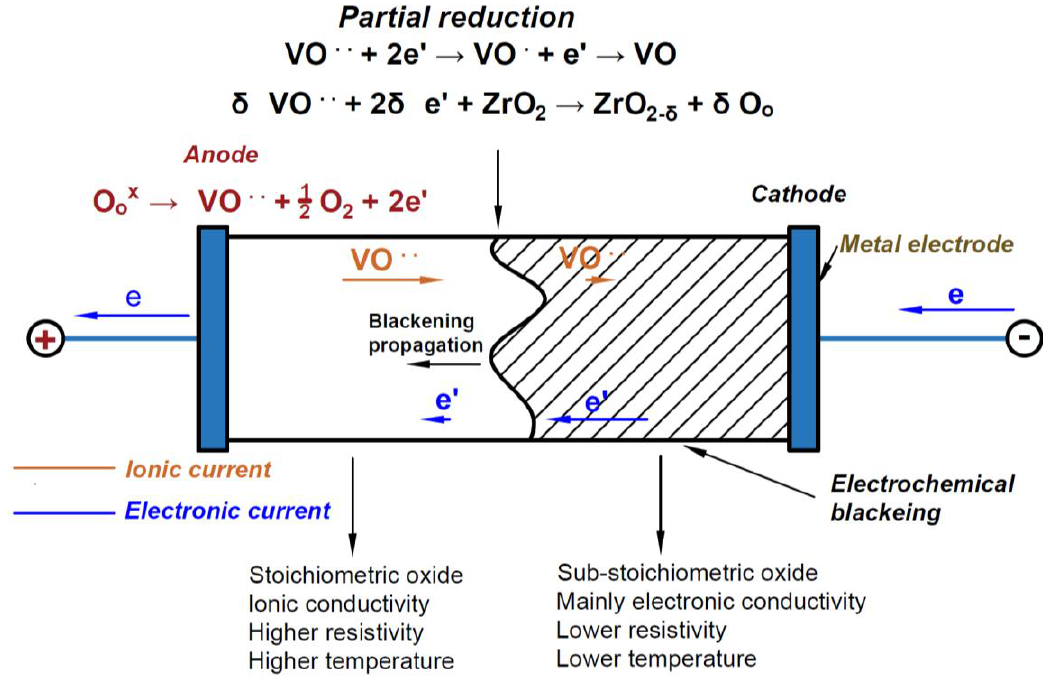
Figure 9. Schematic representation of the electrochemical reactions and of the blackening propagation in 8YSZ subjected to a flash sintering experiment. Drawn using [41] as reference.